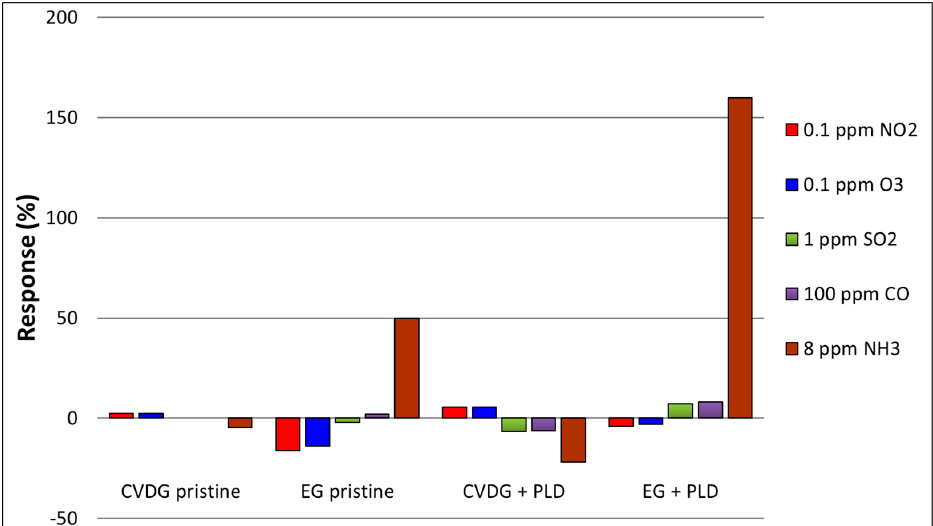
Figure 7. Comparison of the response amplitudes to different polluting gases of CVD graphene and epitaxial graphene sensors with and without laser deposited V 2 O 5 layer.